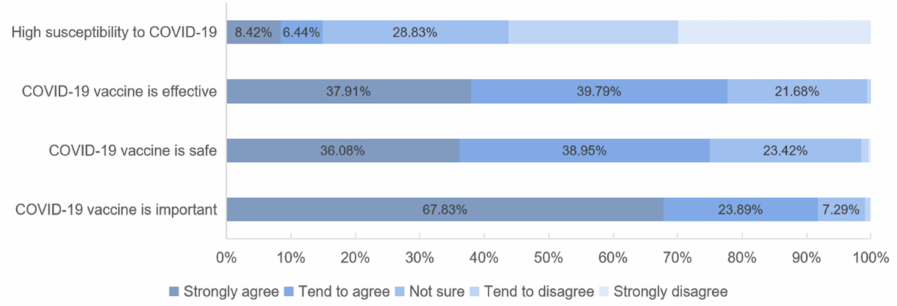
Figure 3. Confidence in COVD-19 vaccine and susceptibility to COVID-19